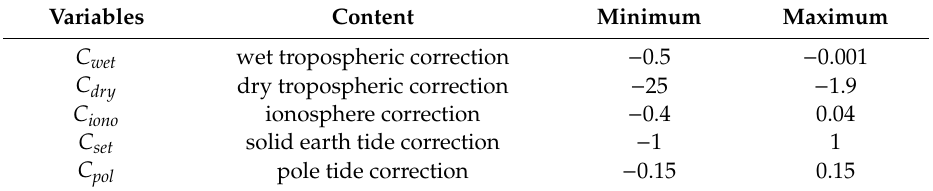
Table 2. Correction threshold editing elements of the Jason series altimetry data (Unit: m).